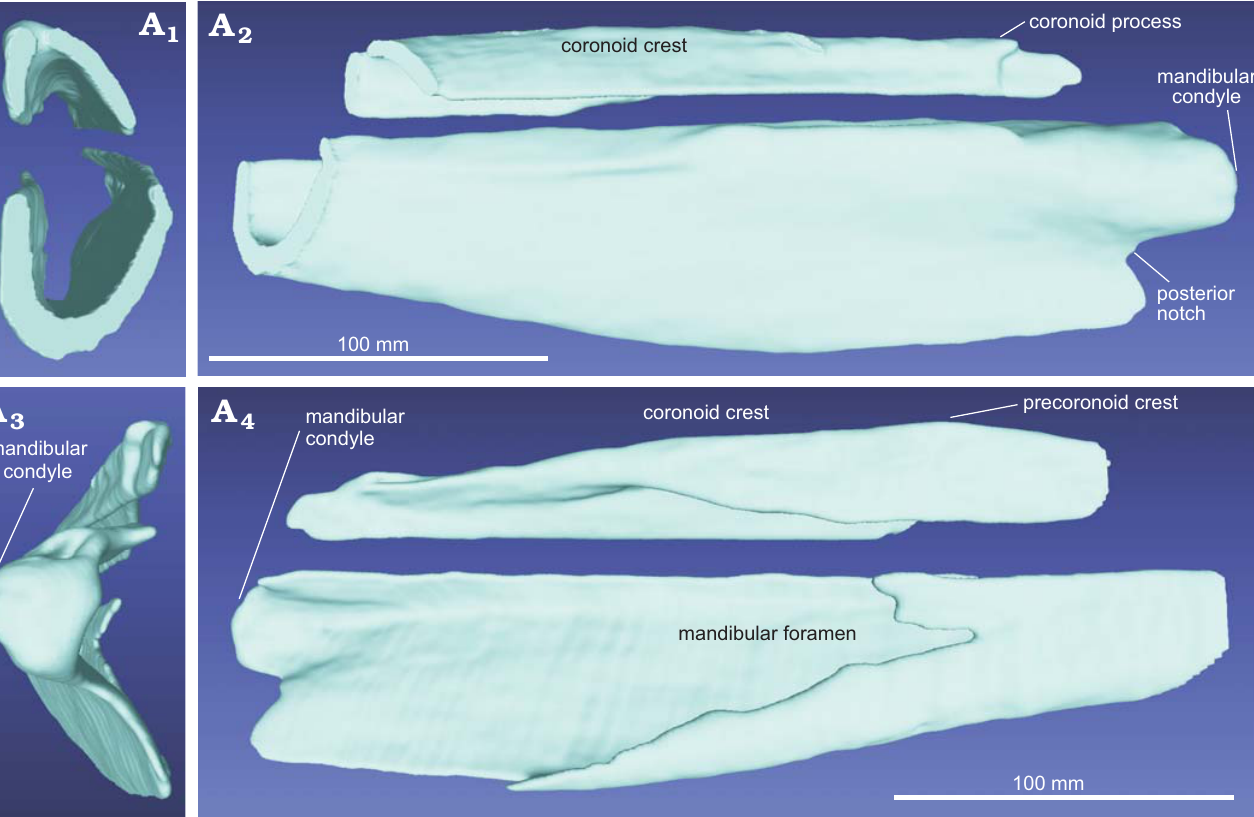
Fig. 9. CT-scan 3D reconstruction of the posterior portion of the left mandible of the ziphiid cetacean Messapicetus cf. longirostris Bianucci, Landini, and Varola, 1992 skull (MDM-2029) inside two limestone slabs from Tortonian of Menorca (Balearic Islands, Spain); in anterior (A 1 ) lateral (A 2 ) posterior (A 3 ), and medial (A 4 ) views.